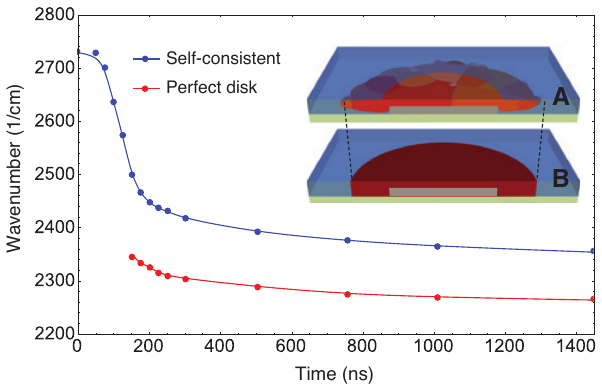
Figure 3: Comparison between idealized and multiphysics descriptions.